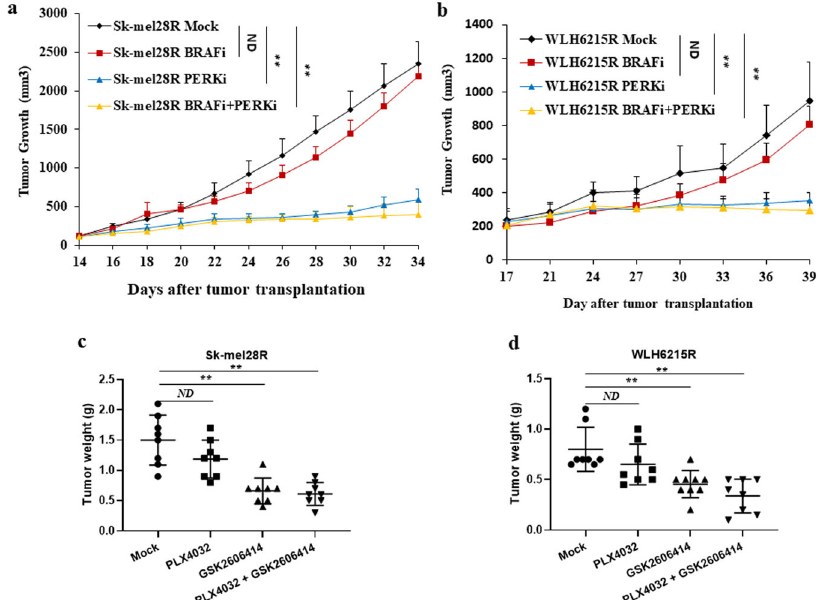
Fig. 6 Inhibition of PERK by a pharmacological inhibitor GSK2606414 blocked tumor growth in vivo. a The growth curves of the resistant Sk-mel28R tumor cells treated with mock (Sk-mel28R Mock, n = 8), BRAF inhibitor PLX4032 (Sk-mel28R BRAFi, n = 8), PERK inhibitor GSK2606414 (Sk-mel28R PERKi, n = 8), or a combination of BRAF inhibitor PLX4032 with PERK inhibitor GSK2606414 (Sk-mel28R BRAFi + PREKi, n = 8). b The growth curves of WLH6215R tumor cells treated with mock (WLH6215R Mock, n = 8), BRAF inhibitor PLX4032 (WLH6215R BRAFi, n = 8), PERK inhibitor GSK2606414 (WLH6215R PERKi, n = 9), or combination of BRAF inhibitor PLX4032 with PERK inhibitor GSK2606414 (WLH6215R BRAFi + PREKi, n = 8). Each point represents mean tumor volume ± s.e.m. ND, no statistical difference; * p < 0.05; ** p < 0.01; *** p < 0.001. c , d The tumor weight (g) of resistant Sk-mel28R ( c ) and WLH6215R ( d ) tumor cells treated with mock (Mock), BRAF inhibitor (PLX 4032), PERK inhibitor (GSK2606414), or a combination of PERK inhibitor GSK2606414 with BRAF inhibitor PLX4032 (PLX4032 + GSK2606414). ND, no statistical difference; * p < 0.05; ** p < 0.01; *** p <